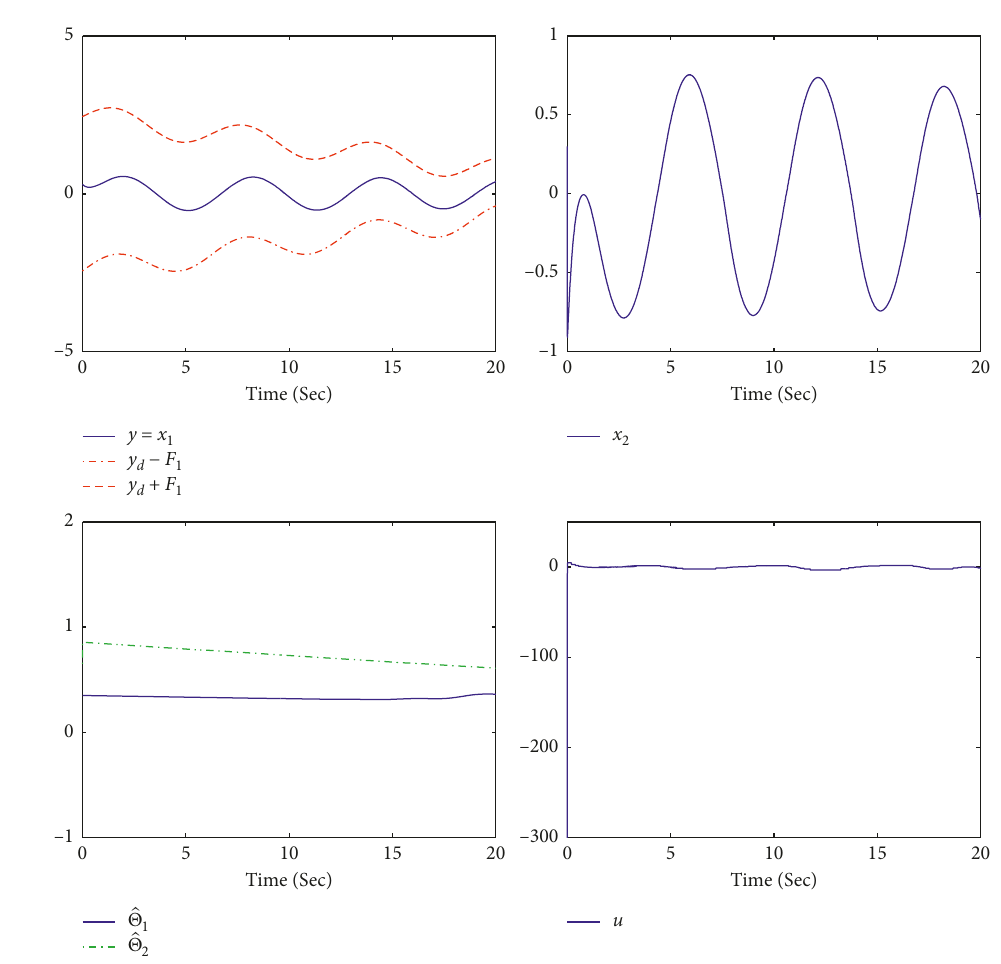
Figure 5: Responses of the closed-loop system (44) and (45).